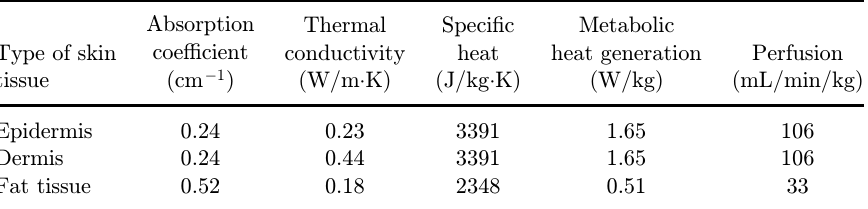
Table 4. Optical and thermal properties of human skin tissue.